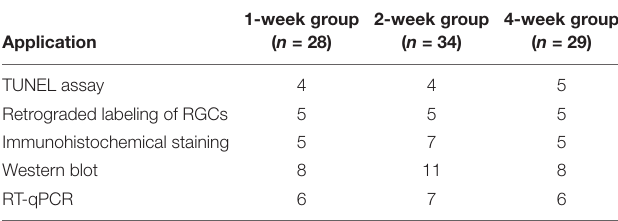
TABLE 1 | Number of eyes used for the